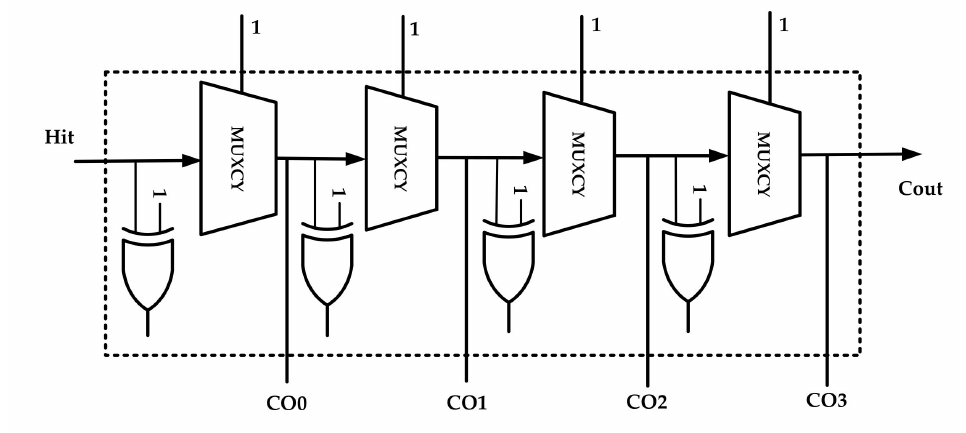
Figure 2. Architecture of a CARRY4